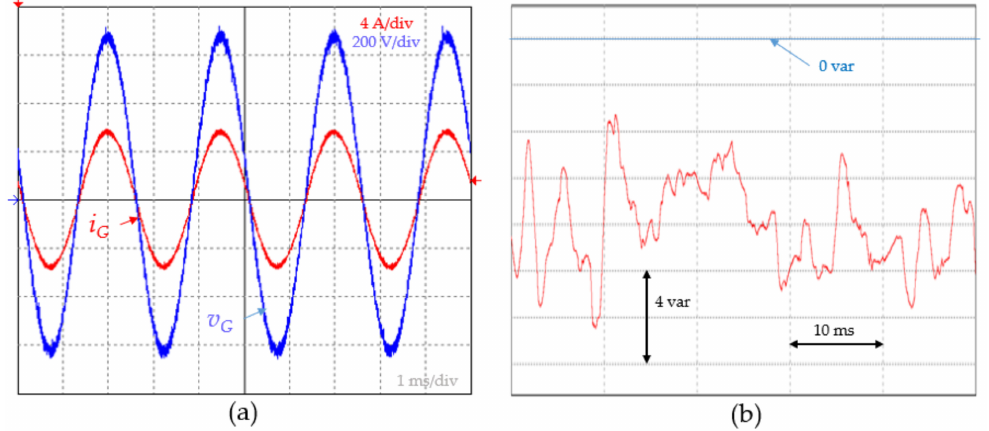
Figure 8. Steady-state waveforms of the on-board grid converter with reactive power compensation recorded for constant temperature of 298 K and solar irradiance of 1000 W/m 2 : ( a ) waveforms of the grid voltage v G and grid current i G ; ( b ) the reactive power for the set value equal